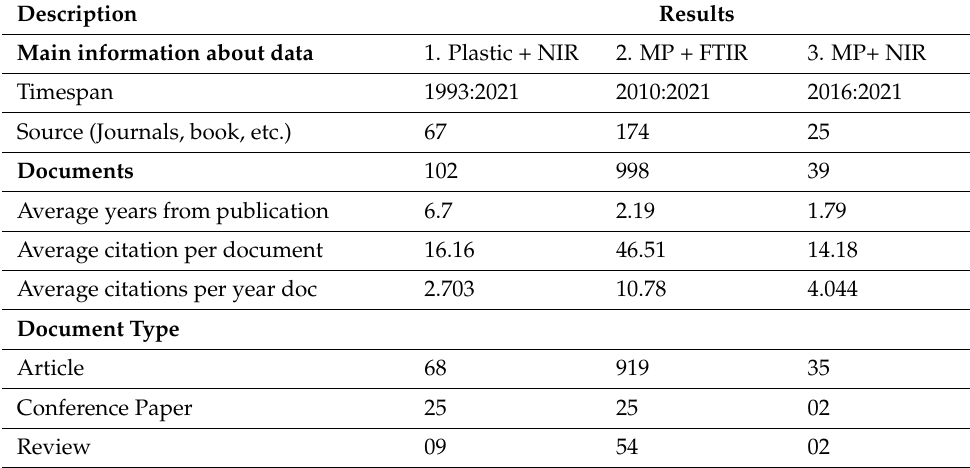
Table 1. General information regarding the data and document type from